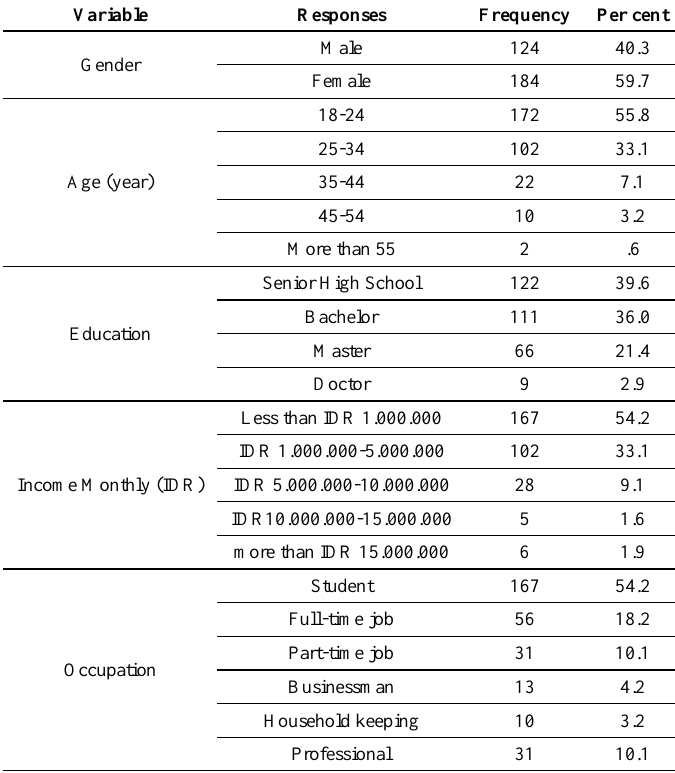
Table 1. Demographic respondent profile